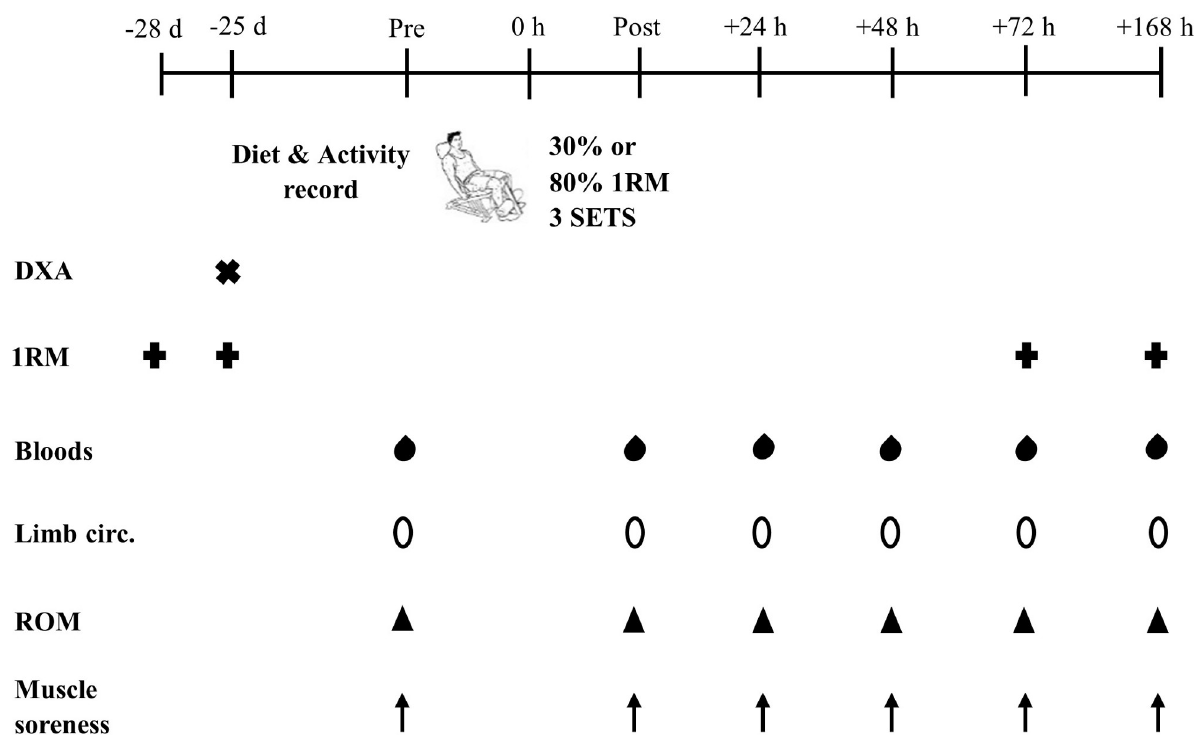
Fig 2. Schematic overview of study design. Note: DXA = dual-energy X-ray absorptiometry; 1RM = one repetition maximum; limb circ. = limb circumference; ROM = range of movement.